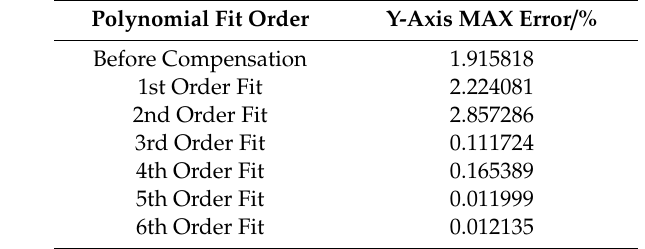
Table 1. Tabulation of percentage errors obtained for each order of polynomial fit and before any calibration is applied.